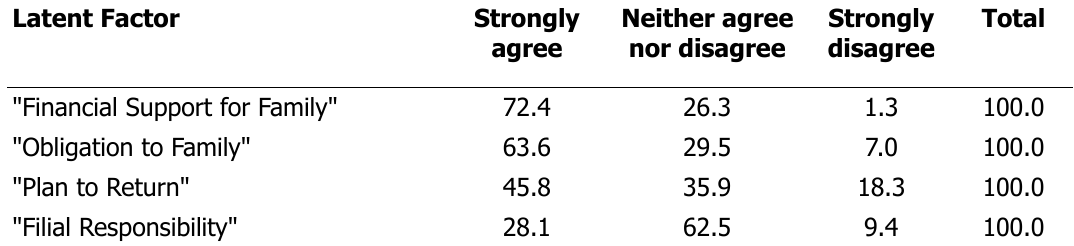
Table 4. Factors and self-reported agreement or disagreement by participants, in %.